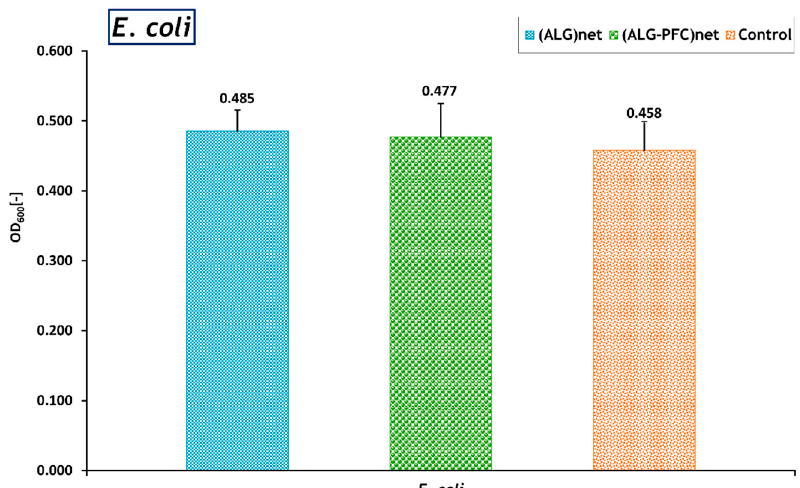
Figure 4. The ratio relative to the control of the optical density (OD) at 600 nm of E. coli bacterial strain cultured in the presence of the (ALG-PFC) net , (ALG) net (control 2). Key to symbols: (ALG-PFC) net —alginate–perfluorooctyl cross-linked; (ALG) net —alginate cross-linked; Control—the bacterial strain cultured without the membrane. The values are presented as the mean ± SD ( n = 6).